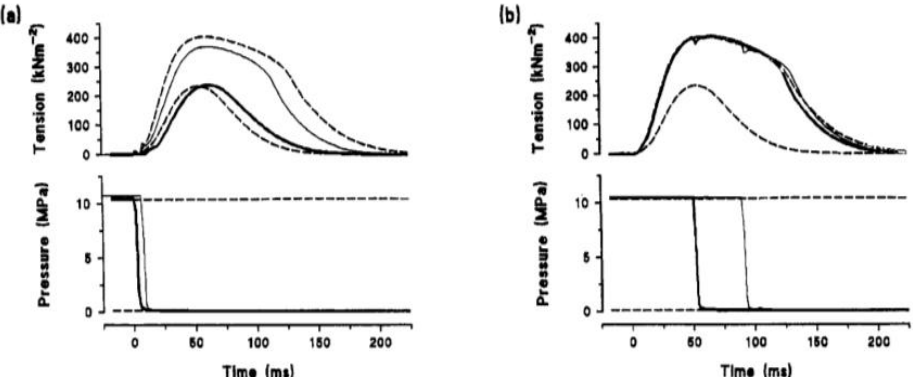
Figure 12. Rapid pressure release from 10 MPa to atmospheric. ( a ) Pressure release during the early part of the twitch and ( b ) during later times. Stimulus is at time = 0: contractions at atmospheric and high (10 MPa) steady pressures are shown by interrupted lines. Note that when pressure is released at 1.5 ms after stimulus, twitch contraction remained similar to atmospheric (unaffected by high pressure).